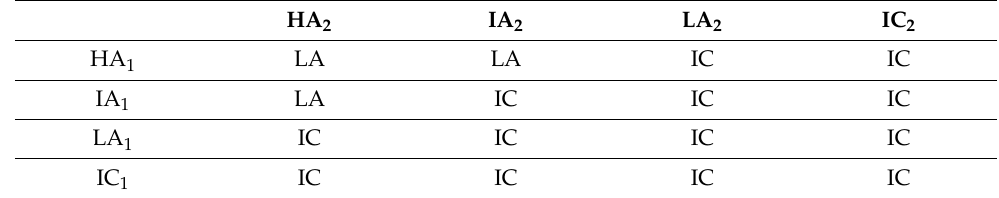
Table A1. The fuzzy rule table when u 3 is IC 3 .